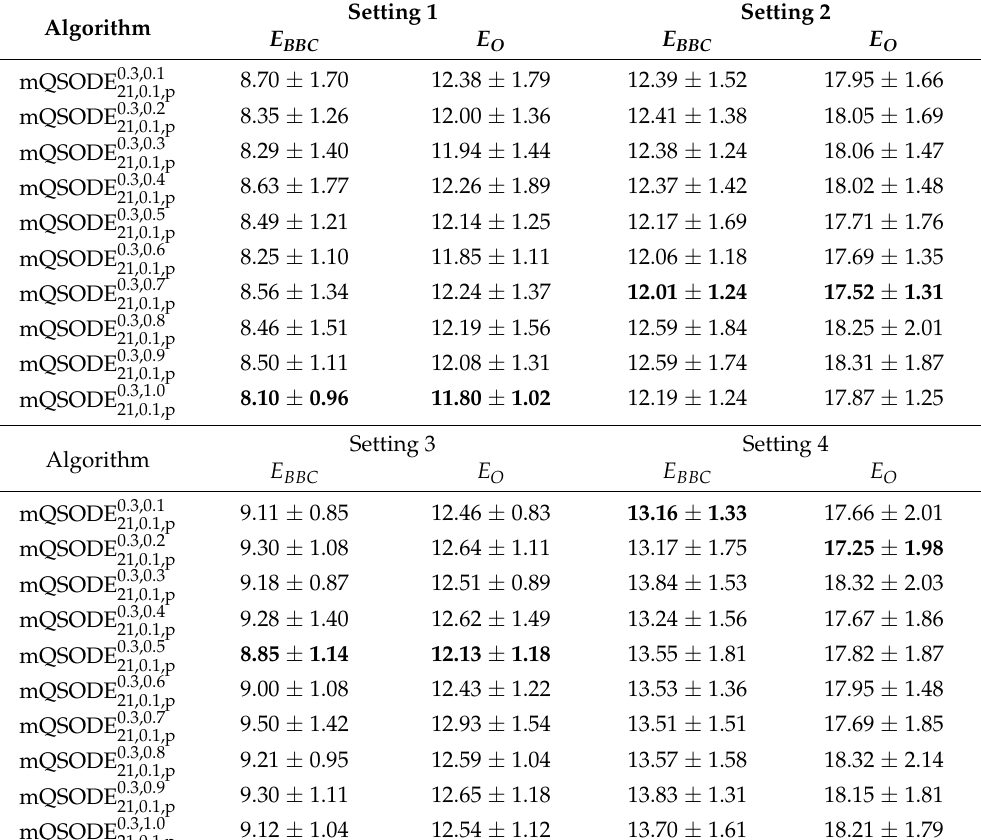
Table 6. Comparison of mQSODE with different crossover